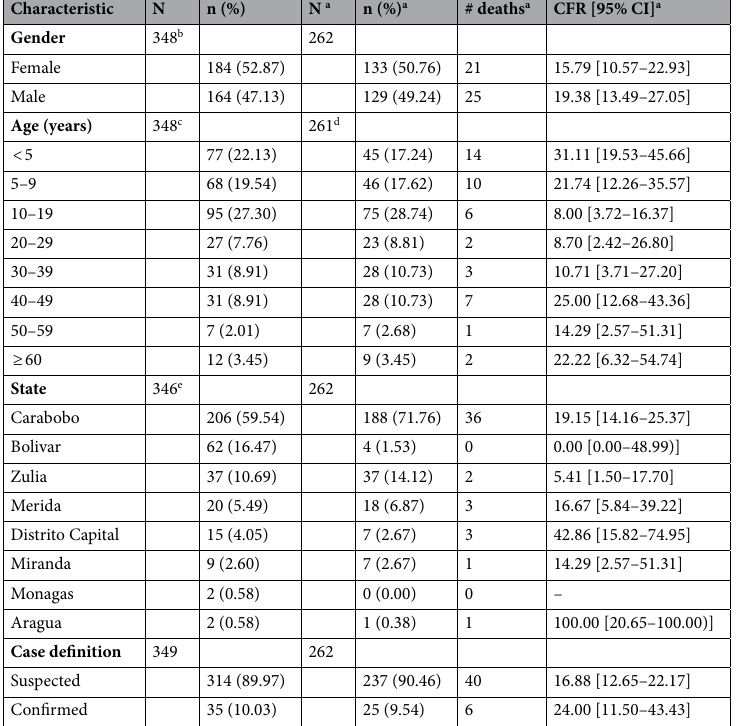
Table 2. Descriptive characteristics of the study population in the diphtheria outbreak (N = 348) reported between June 2016 and July 2019 in Venezuela (retrospectively retrieved from study hospital records). N, n sample size; CFR case fatality rate; CI confidence interval. a Excluding observations with missing survival status. b Missing gender information in 1 patient. c Missing age information in 1 patient. d Missing age information in 1 patient. e Missing state information in 3